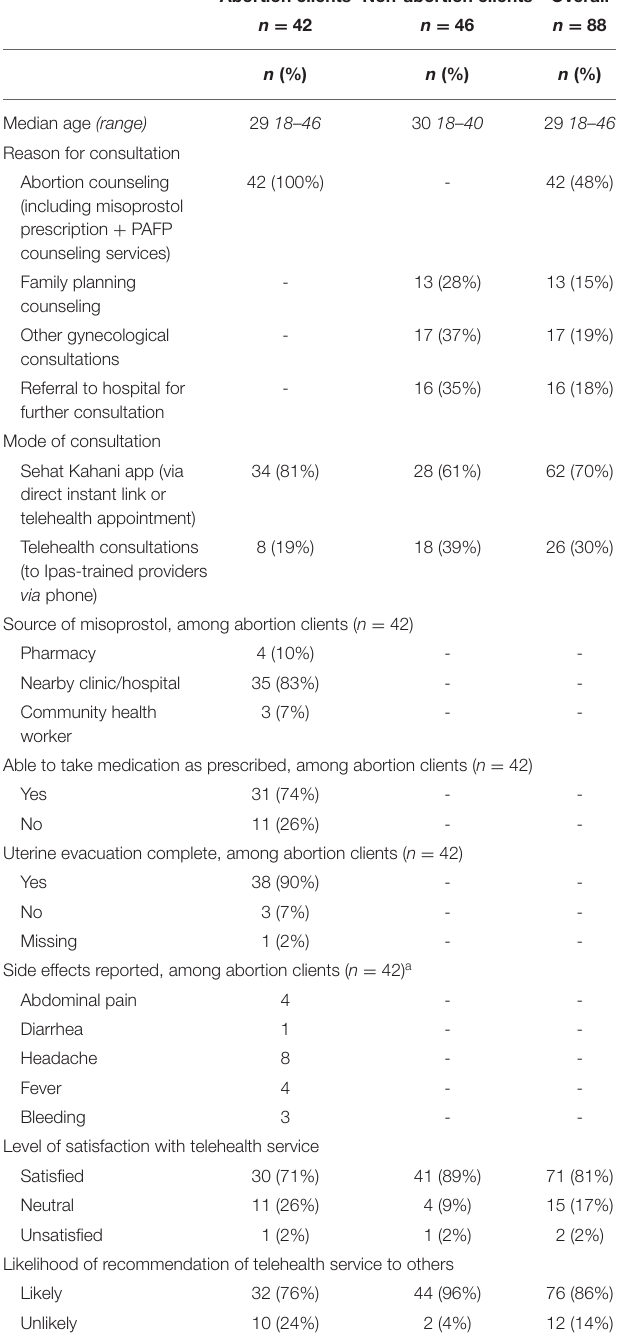
TABLE 2 | Monitoring Data ( n =